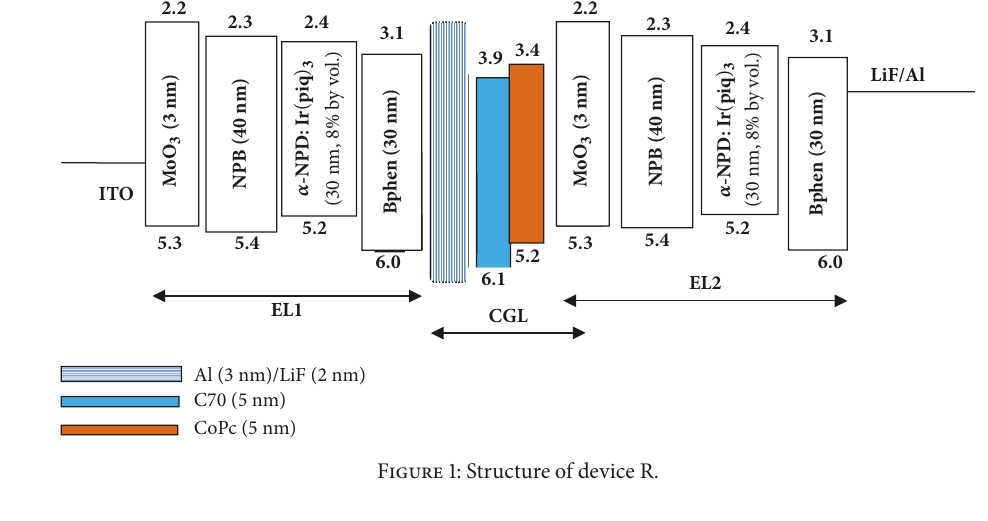
Figure 1: Structure of device R.